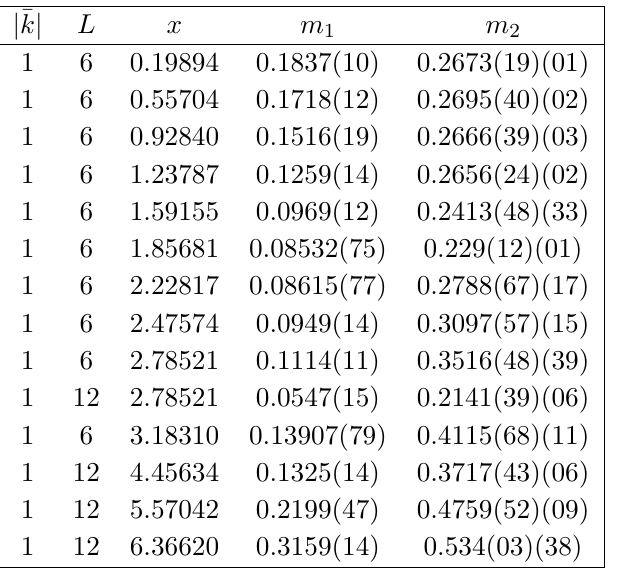
Table 21. Mass gap and next excited state energy (in lattice units) in the zero-electric (cid:13)ux scalar sector for